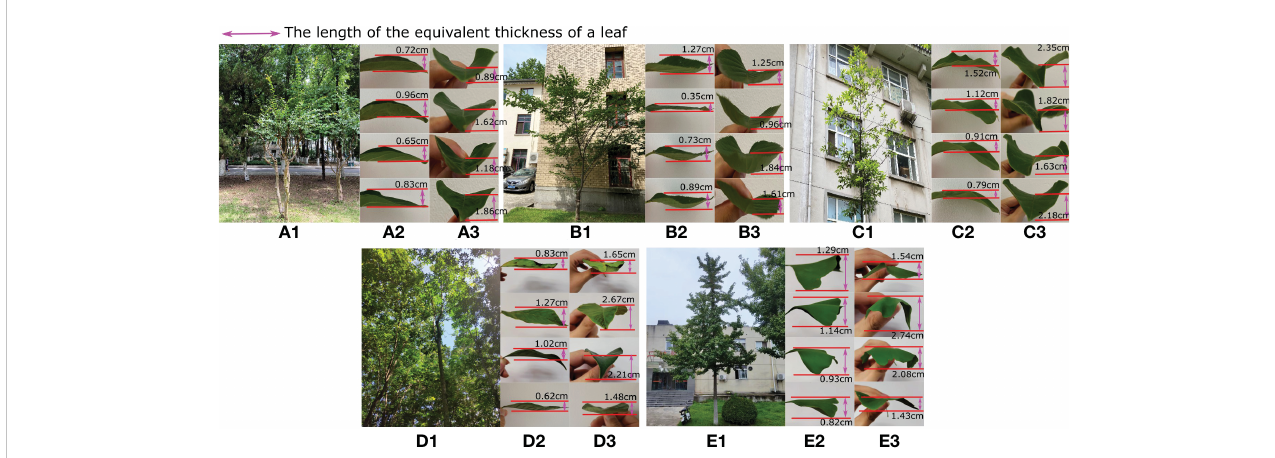
FIGURE 2 Sample leaves were collected from some test trees, namely, (A) crepe myrtle, (B) sakura, (C) magnolia, (D) rubber and (E) ginkgo tree, shown from the lateral side (a2-e2) and parallel to the leaf midrib (a3-e3). Each leaf displays different degrees of curling and drooping, which in fl uence the equivalent leaf thickness, as indicated by the double-sided pink